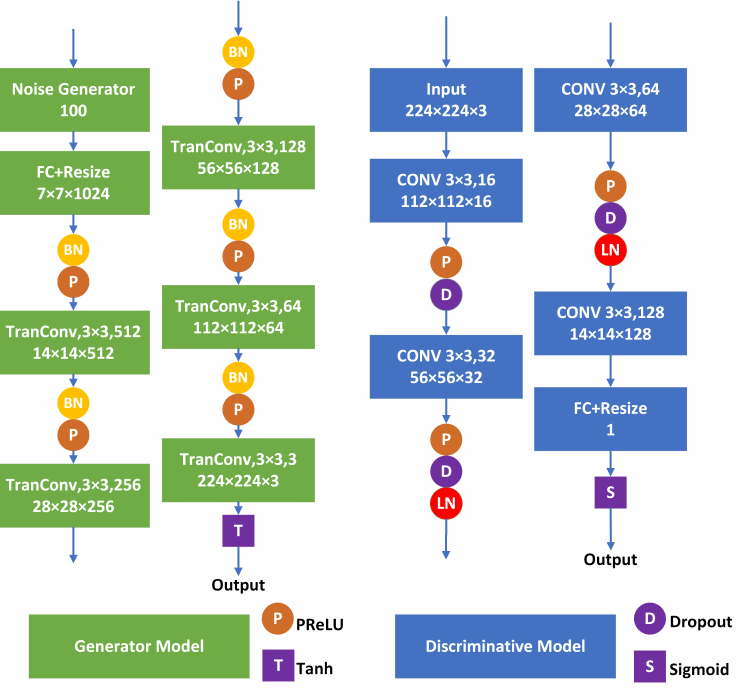
Figure 8. Flow of